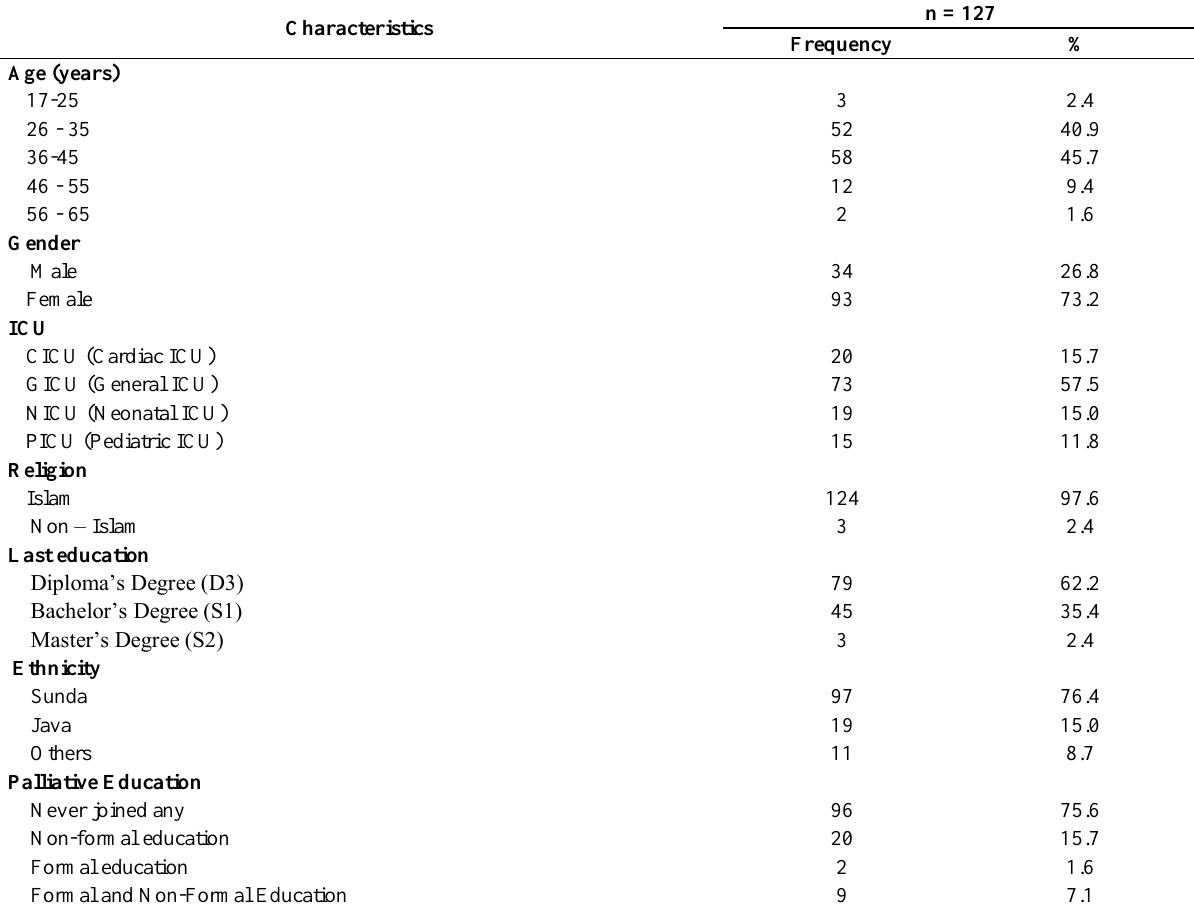
Table 1 Characteristics of ICU Nurses in General Hospital in Bandung